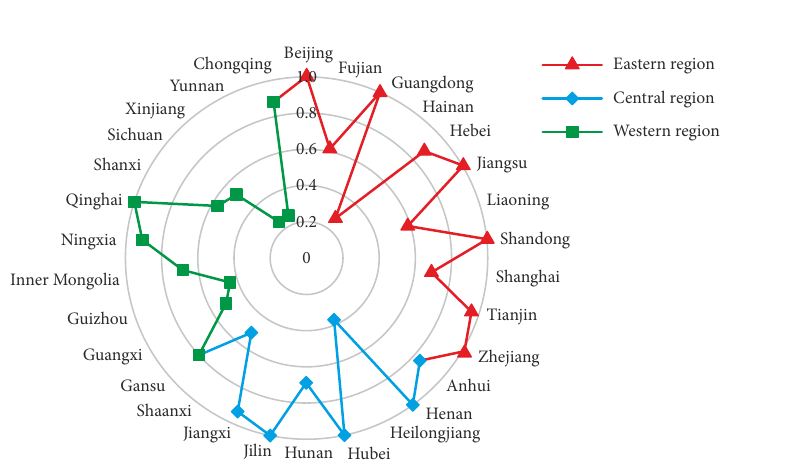
Figure 5. Average efficiency of application stage